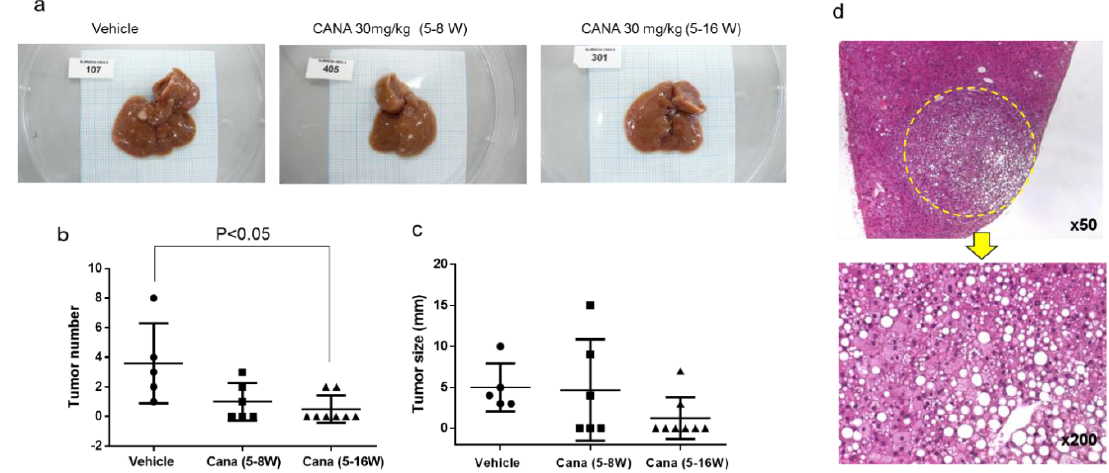
Figure 4. Canagliflozin inhibited liver tumorigenesis. ( a ) Representative images of the whole of liver in the three groups. ( b,c ) The number and size of liver tumors in the three groups. ( d ) Histological findings of H-E showing that the tumor was HCC.